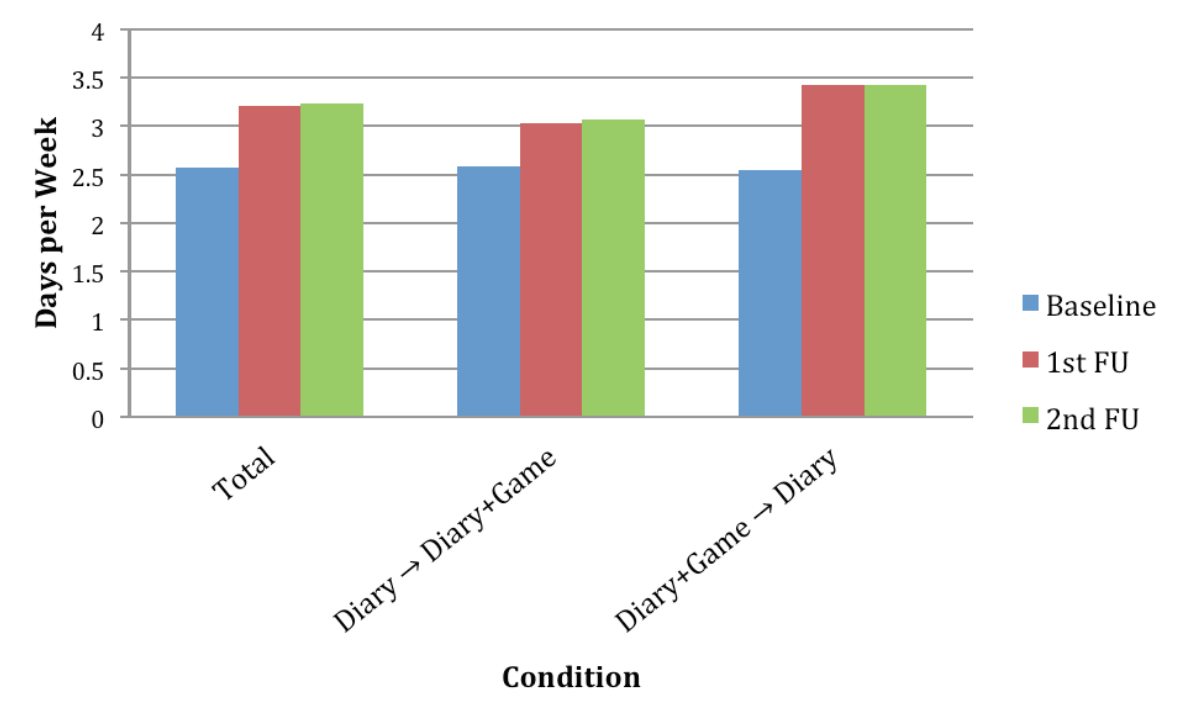
Figure 3. Exercise days per week at baseline, first, and second FU overall (total) and by Diary first versus Diary+Game first. The exercise frequency increase was greater in the Diary+Game first